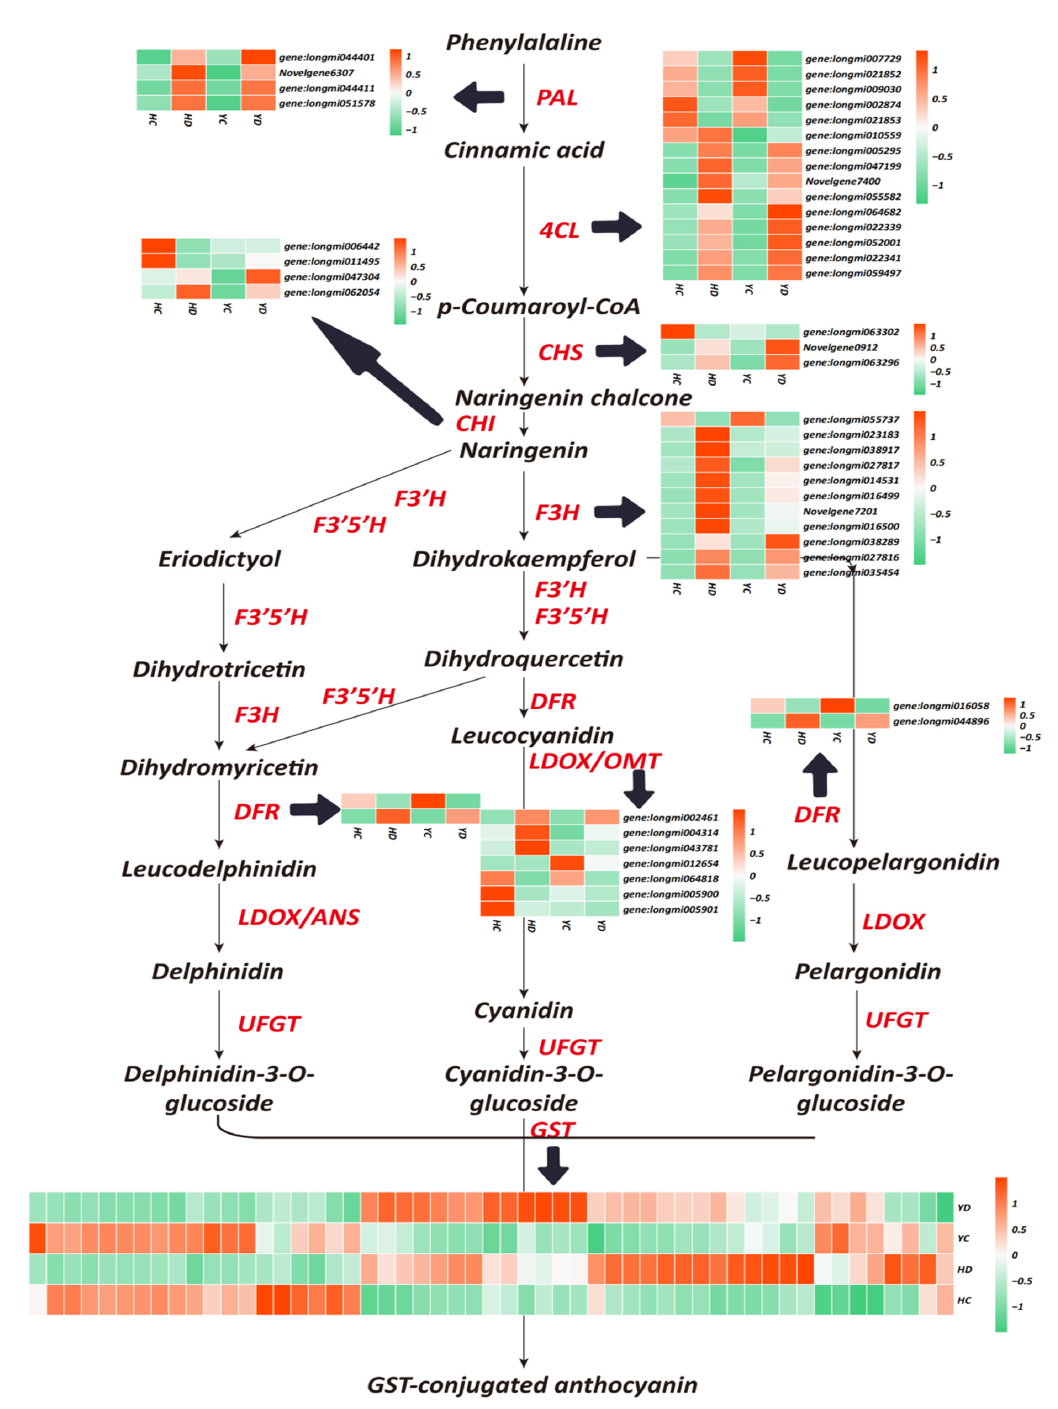
Figure 3. Heat map diagrams of the relative expression levels of anthocyanin biosynthesis- related structural genes in response to DR. PAL: phenylalanine ammonia lyase; C4H: cinnamate 4-hydroxylase; 4CL: 4-coumaroyl-CoA ligase; CHS: chalcone synthase; CHI: chalcone isomerase; F3H: flavanone 3-hydroxylase; DFR: dihydroflavonol-4-reductase; OMT: O-methyltransferase; and GST: glutathione